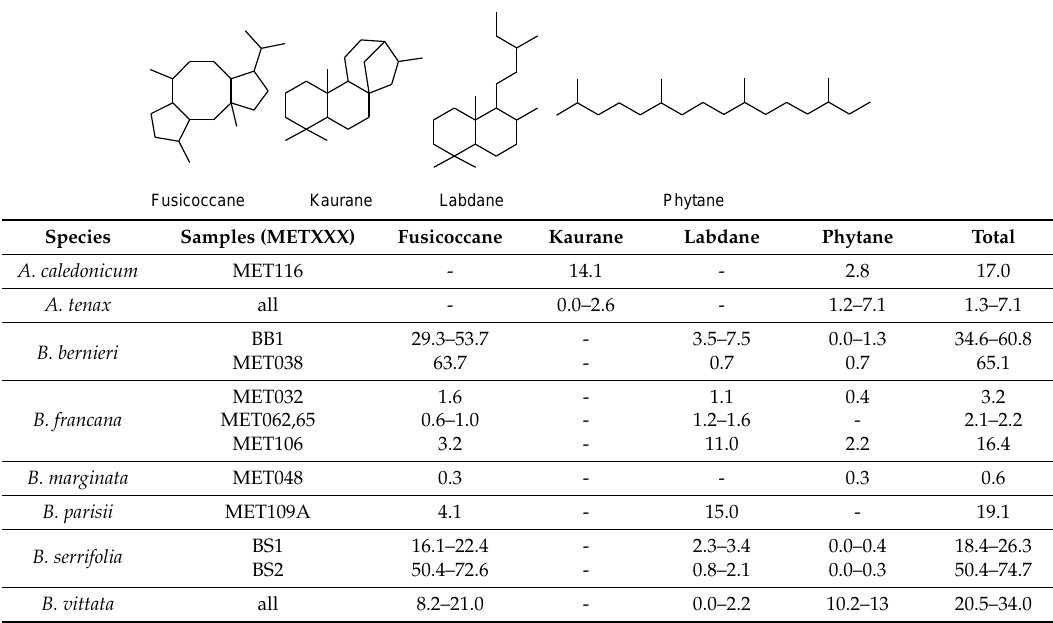
Table 3. Distribution of fusicoccane-, kaurane-, labdane- and phytane-type diterpenes in studied species.